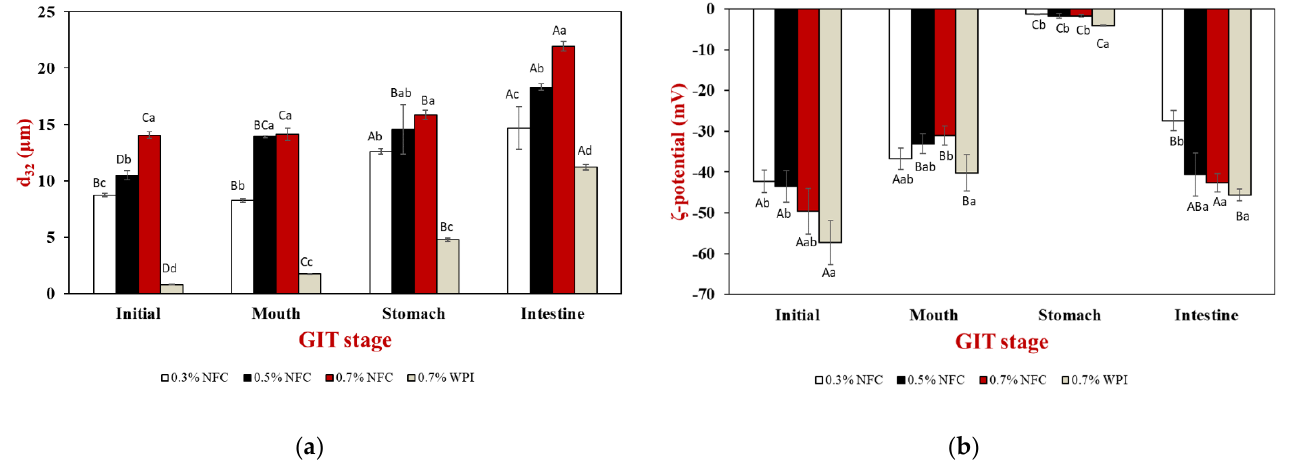
Figure 3. Effects of emulsifier concentrations on ( a ) mean particle diameter (d 32 ) and ( b ) ζ -potential values of AX-loaded emulsions. Different uppercase letters (A–C) indicate significant ( p ≤ 0.05) comparisons between different GIT stages (same emulsifier concentrations). Different lowercase letters (a–d) indicate significant ( p ≤ 0.05) comparisons between different emulsifier concentrations (same GIT stage).